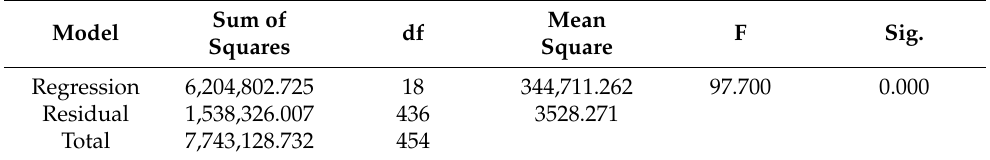
Table 9. F-Test of general linear regression model.